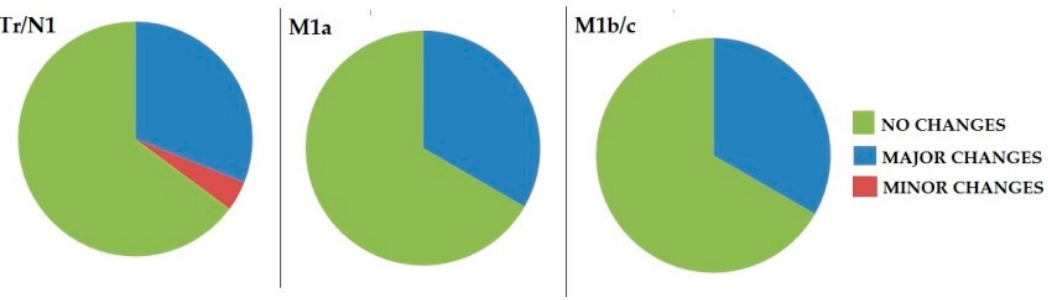
Figure 5. Graph illustration of the therapeutic changes determined by 18 F-FACBC PET/CT in patients classified according to modified PROMISE reading approach.